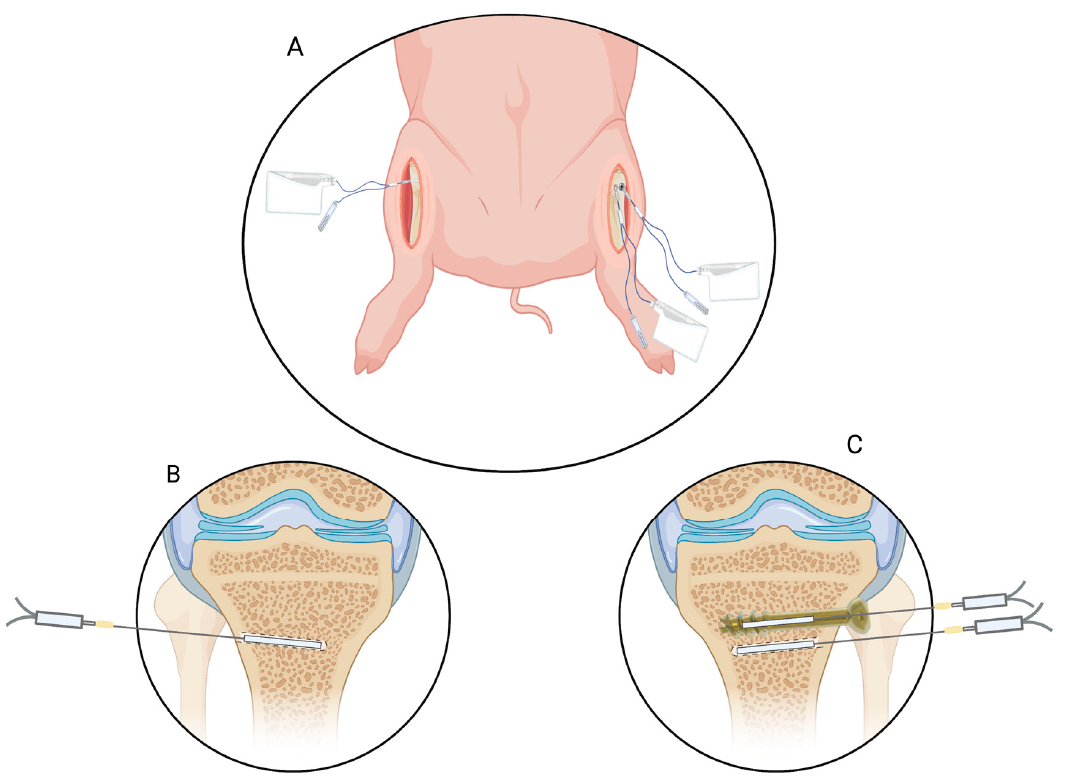
Figure 2. ( A ), illustrative drawing of the placement of the microdialysis catheters in the proximal left and right tibial bone. ( B ), microdialysis catheter placed in a drill hole in the cancellous bone in the contralateral right tibia. ( C ), left tibia: a microdialysis catheter placed in the cannulated screw, and a microdialysis catheter plasced in a drill hole in the cancellous bone approximately 2–4 mm next to the cannulated screw in parallel direction in the axial plane. The illustrated frontal plane in C is for exemplification. Figure 2 was made using Biorender with permission for publication from Biorender [40].